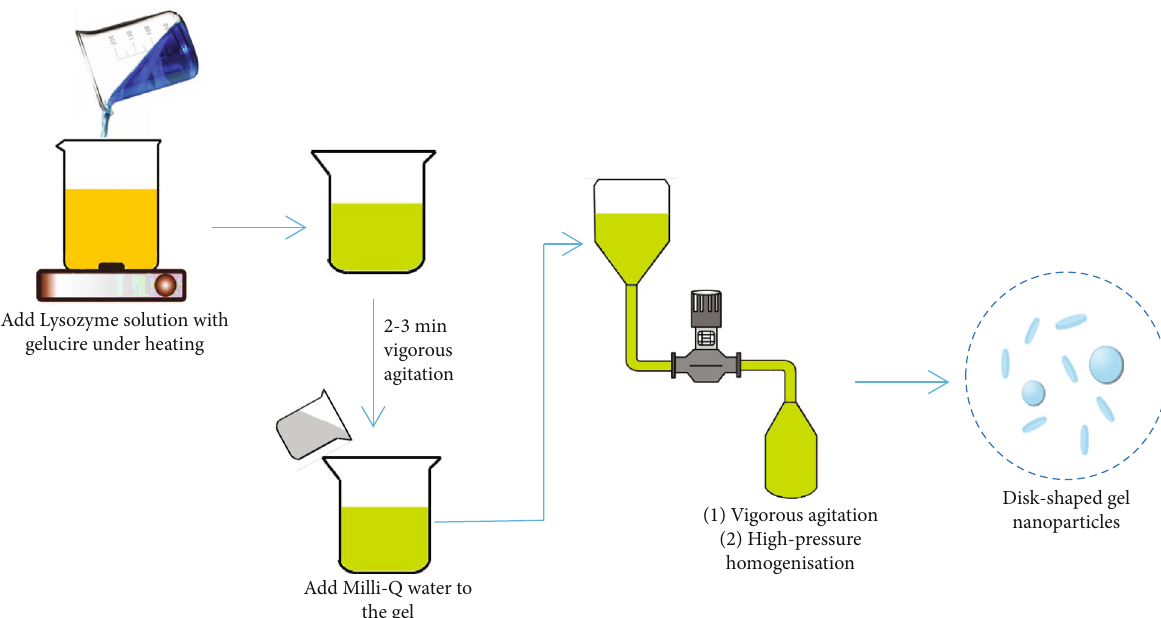
Figure 5: Schematic illustration of the fabrication process of lysozyme-loaded disc-shaped gel